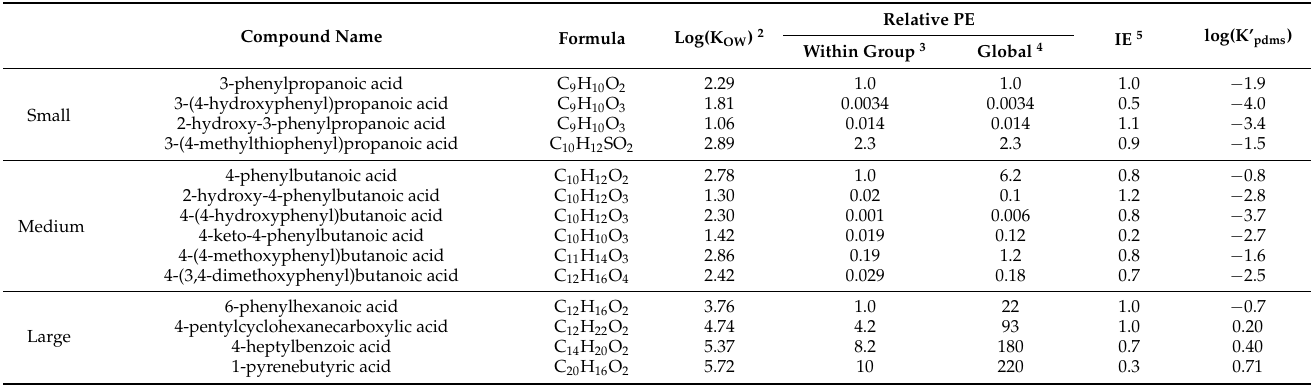
Table 2. Relative permeation efficiency (PE 1 ) across PDMS membrane using CP-MIMS with 15/85